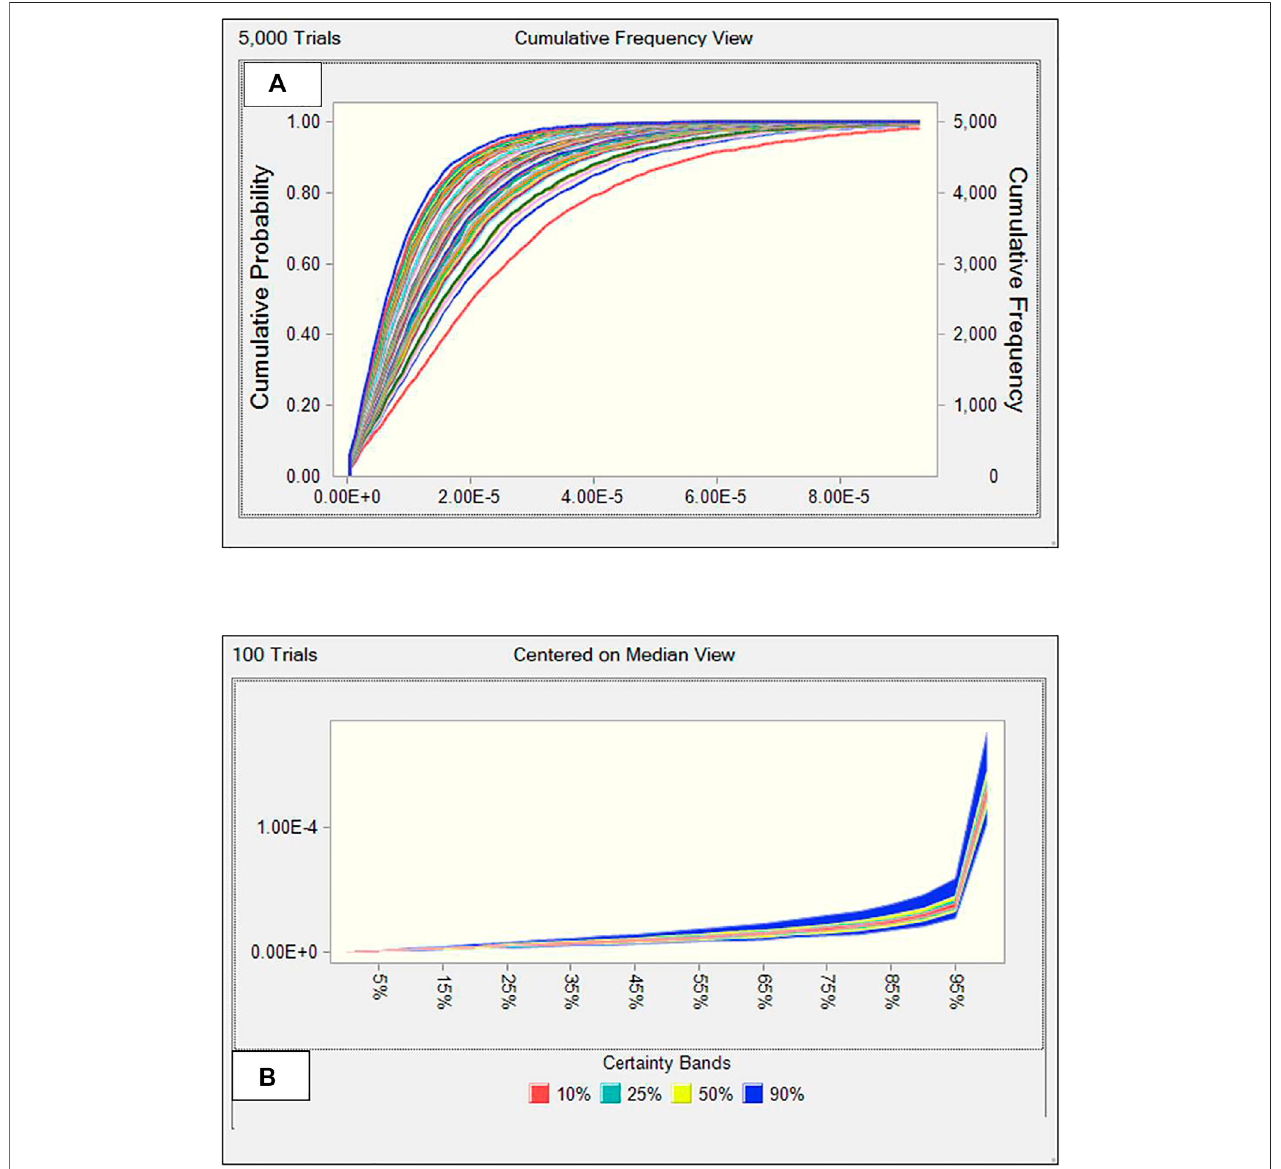
FIGURE4| Two-dimensionalsimulation plotsofvariability and uncertainty (A) overlay chartofriskcurves forteen and adultsand (B) trendchartofcertainty bands for teen and adults at Ulsan.